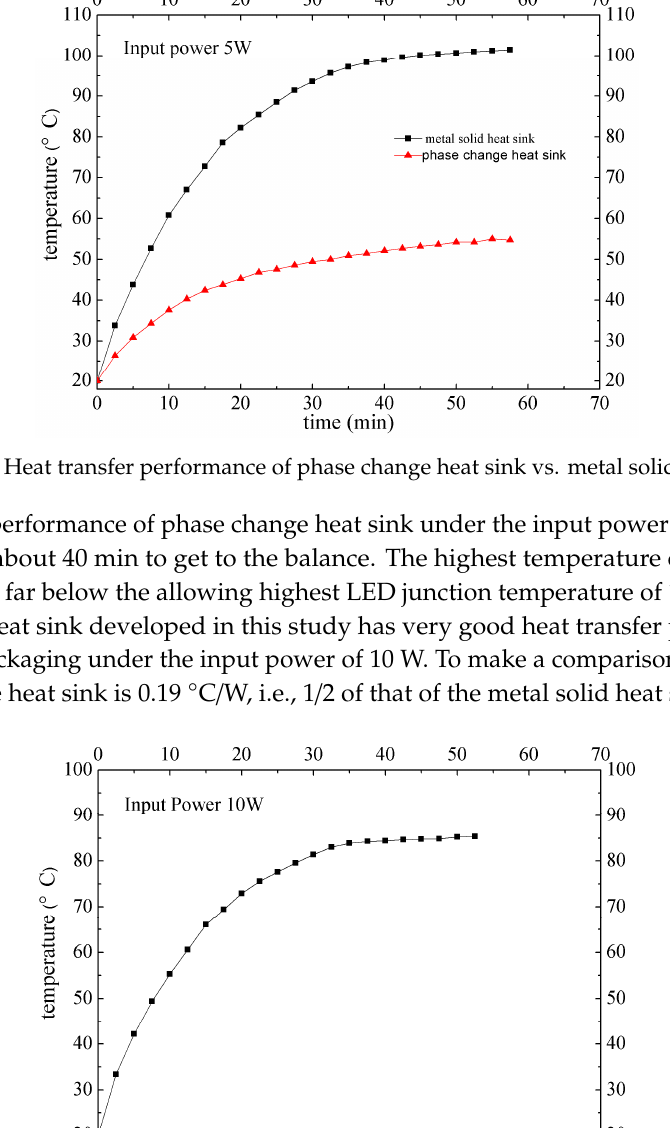
Figure 17. Heat transfer performance of phase change heat sink under the input power of 10 W.